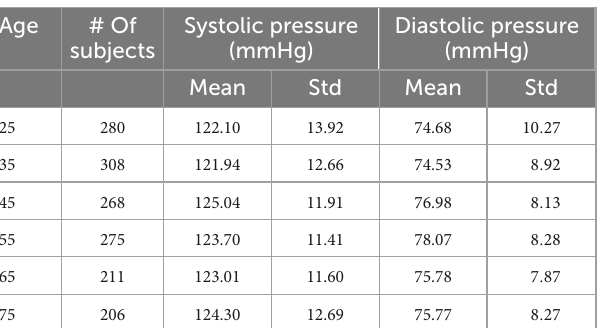
TABLE 4 Outcome of the ageing model: Brachial